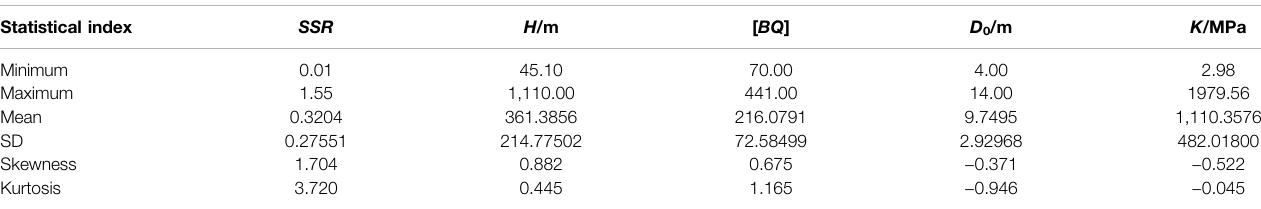
TABLE 2 | The basic statistical description of fi ve prediction variables.